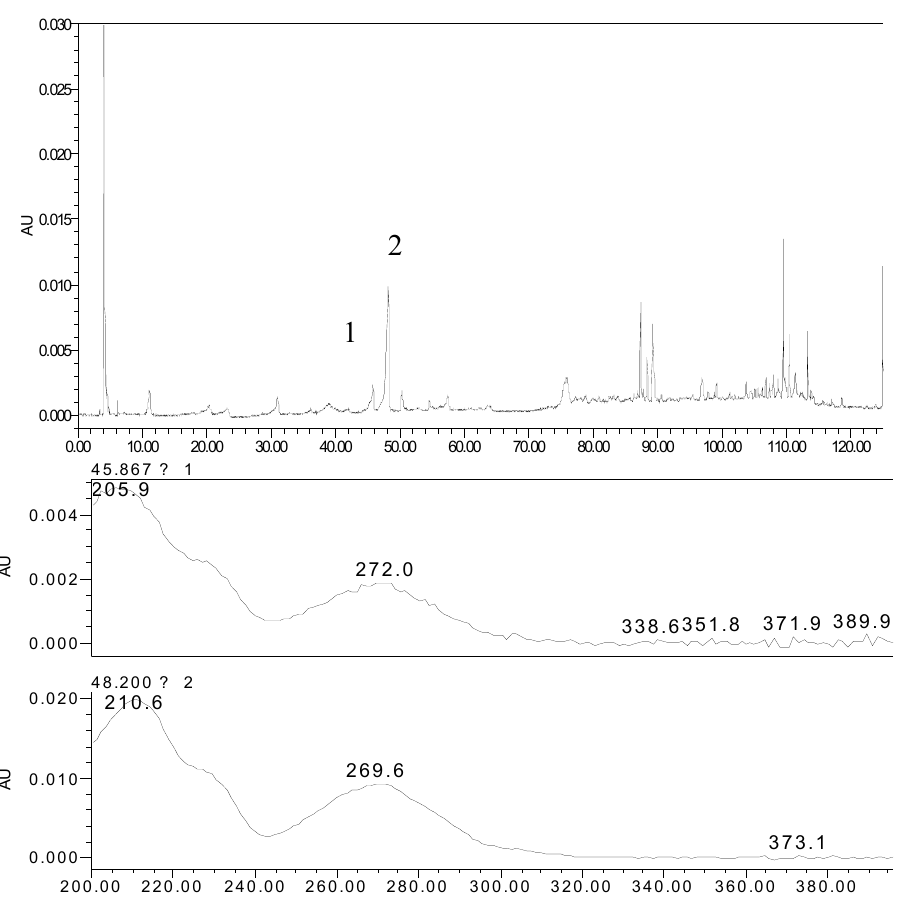
Figure 2. HPLC and UV spectra of the plasma sample after intragastric administration of the extract of Nelumbo nucifera